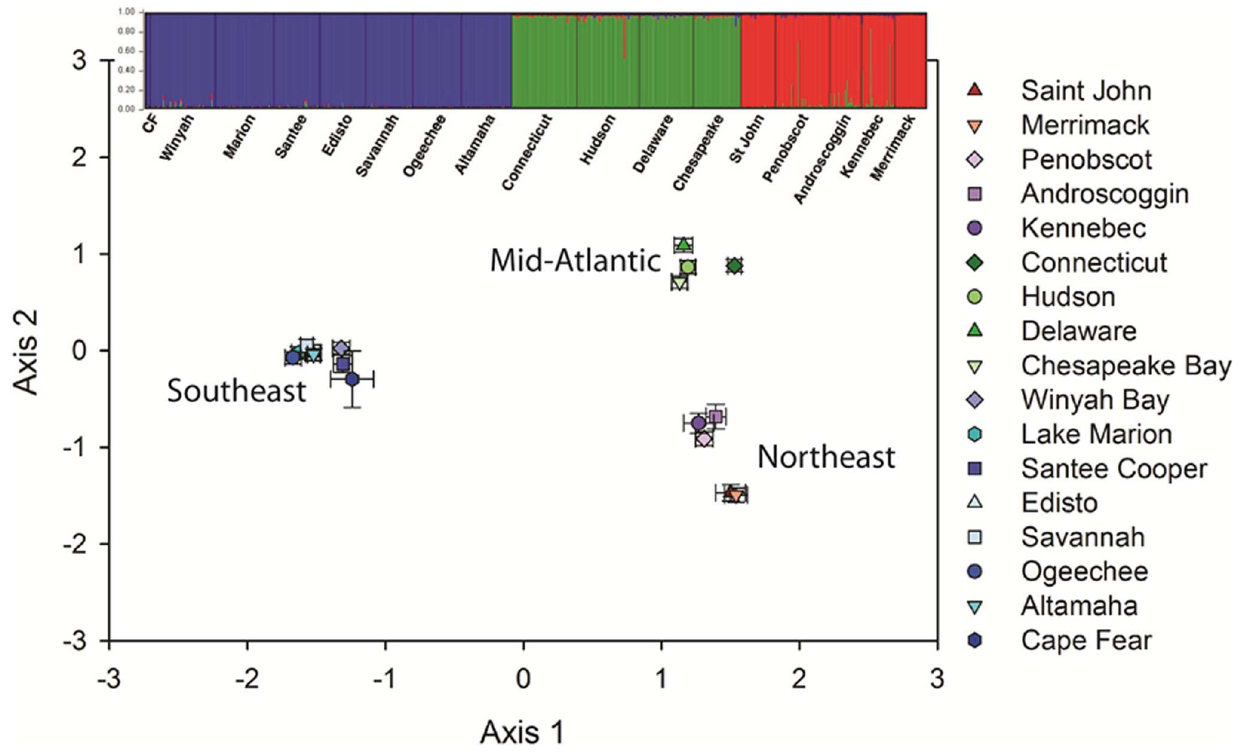
Figure 2. Combined graphical representation of principal coordinates (scatter plot) and STRUCTURE (histogram) analyses of 561 shortnose sturgeon ( Acipenser brevirostrum ) from 17 locations along the North American coast, surveyed at 11 polysomic microsatellite DNA loci. For the STRUCTURE histograms, each individual is represented by a single vertical bar, broken into k colored segments, the length of which is proportional to the membership fraction in each of the k clusters. Black lines partition the river samples.